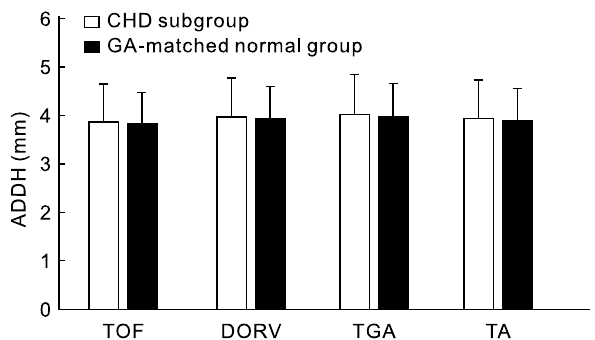
Figure 5 ADDH differences between other heart abnormalities and GA- matched normal subgroups. ADDH, aortic diameter at the diaphragmatic; CHD, congenital heart disease; GA, gestation age; VSD, ventricular septal defect; AVCD, atrioventricular canal defect; SV, single ventricle; VR, vascular ring; APVR, anomalous pulmonary venous return.